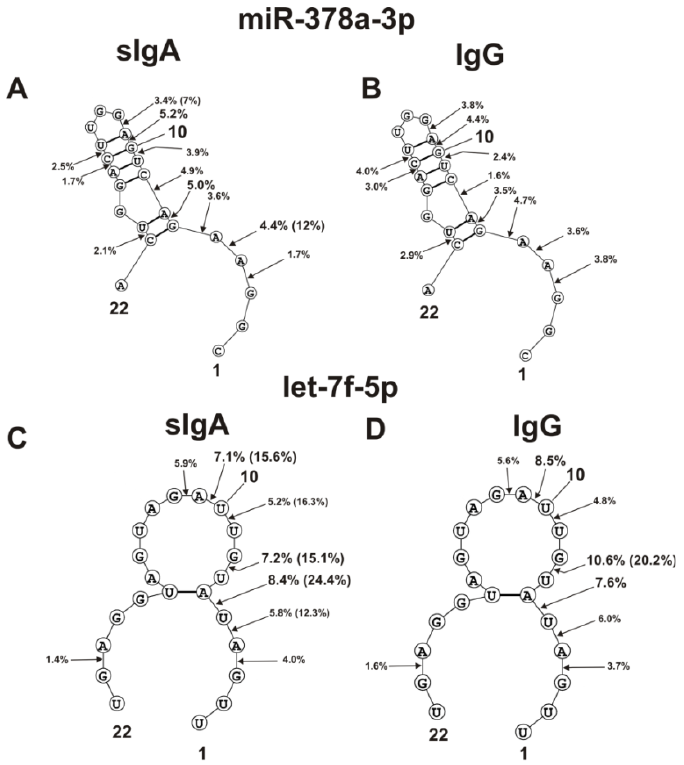
Figure 5. The average efficiencies of Flu-miR-378a-3p ( A , B ) and Flu-let-7f-5p ( C , D ) hydrolyzed by seven sIgAs ( A , C ) and IgGs ( B , D ) from human milk plasma, in all sites of their cleavage. The average percentages of microRNAs and cleavage positions in different microRNA hydrolysis sites by antibodies are shown using spatial models of microRNAs. Values in parentheses indicate the efficiencies of microRNA hydrolysis at individual sites by some preparations, with an increased specific activity in relation to these sites. Numbers 1, 10, 22 correspond to the terminal RNA nucleotides.